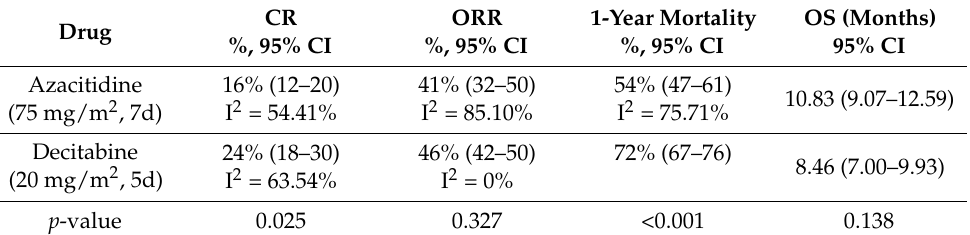
Table 3. Summary of response outcomes, overall survival and mortality during azacitidine (75 mg/m 2 , 7d) and decitabine treatment (20mg/m 2 , 5d) in monotherapy.